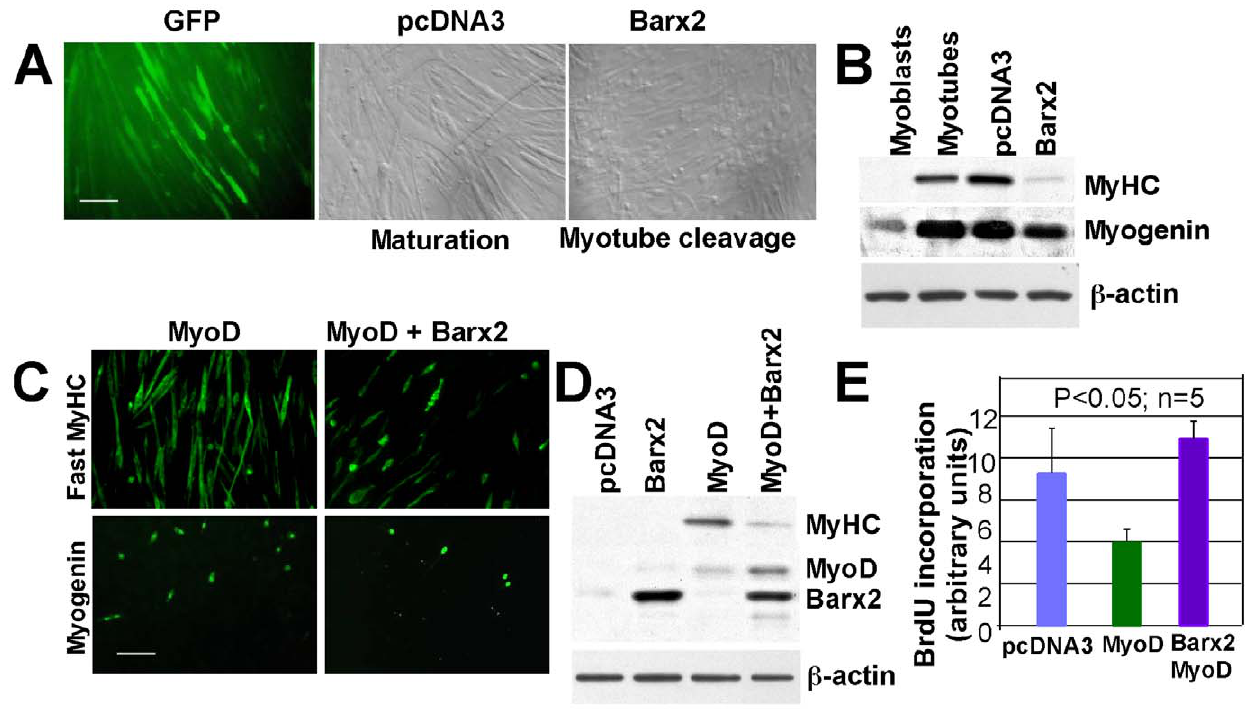
Figure 1. Ectopic expression of Barx2 in differentiated myotubes causes their dedifferentiation. A. Serum-deprived C2C12 cultures contaning many early myotubes were transfected with either Barx2/pcDNA, empty pcDNA3, or GFP-expressing plasmids. Images of maturing or apparently fragmenting myotubes were taken after 3–4 days, B. Levels of the differentiation-associated proteins myogenin and myosin heavy chain (MyHC) were measured by immunoblotting of total protein from Barx2-expressing and control cultures corresponding to those shown in A. Untransfected myoblast and myotube cultures were also analysed as a reference. C. C3H10T1/2 mesenchymal progenitor cells were transfected with either MyoD/pcDNA3 or a combination of MyoD/pcDNA3 and Barx2/pcDNA3 plasmids and differentiation was subsequently induced by serum withdrawal for 2–3 days. The proportion of cells expressing myogenin and MyHC and appearance of myotubes was assessed by immunostaining. D. MyHC protein was assessed by immunoblotting of total protein from cultures corresponding to those shown in C and D. Analysis of BrdU incorporation was performed in C3H10T1/2 cultures corresponding to those shown in C ; co-expression of Barx2 with MyoD increased numbers of proliferating cells relative to MyoD alone - E